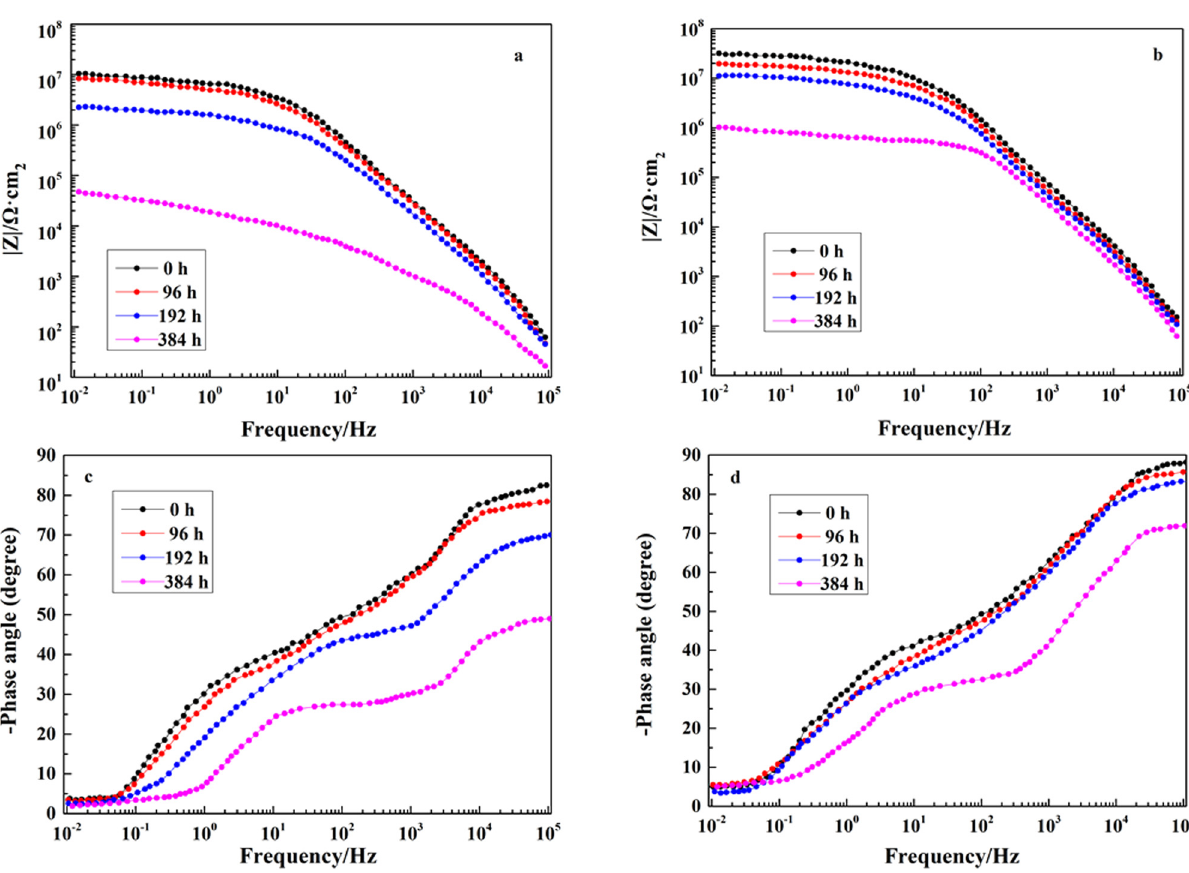
Figure 7: Bode modulus plots ( a ) , Bode phase plots ( c ) of EL@AR - P 0 , Bode modulus plots ( b ) , Bode phase plots ( d ) of EL@AR - P 2 .